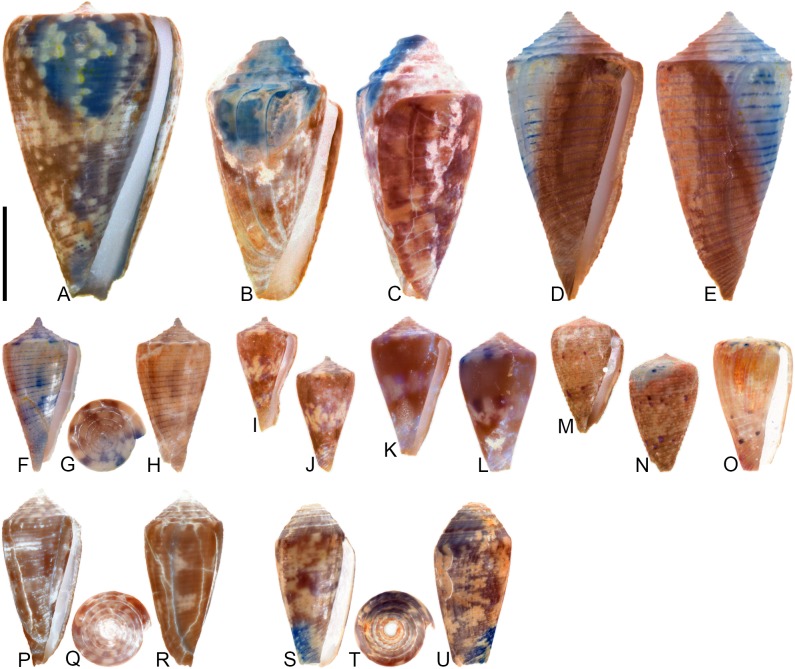
Unidentified Conidae spp.Specimens are from locality stations TU 1422 (Cercado Fm.), TU 1215 (Gurabo Fm.), and TU 1354 (Gurabo Fm.). (A) Conidae sp. 1, PRI 66169, TU 1422, SL 30.5 mm; (B-C) Conidae sp. 2, PRI 66186, TU 1354, SL 26.6 mm; (D-E) Conidae sp. 3, PRI 67243, TU 1354, SL 29.2 mm; (F-H) Conidae sp. 4, PRI 67566, TU 1215, SL 16.3 mm; (I-J) Conidae sp. 5, PRI 67234, TU 1422, SL 11.8 mm; (K-L) Conidae sp. 6, PRI 67233, TU 1422, SL 14.1 mm; (M-N) Conidae sp. 7, PRI 66167, TU 1422, SL 11.9 mm; (O) Conidae sp. 8, PRI 67571, TU 1215, SL 14.3 mm; (P-R) Conidae sp. 9, PRI 66149, TU 1215, SL 18.8 mm; (S-U) Conidae sp. 10, PRI 66145, TU 1215, SL 17.4 mm. All are reversed images of specimens photographed under UV light. Scale bar is 1 cm and pertains to all images.